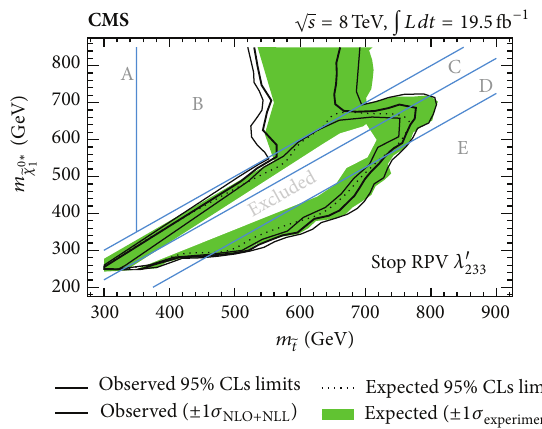
Figure 7: The 95% CL limits in the stop and bino mass plane for stop-pair production and RPV coupling 𝜆 󸀠 233 (from [41]). The different kinematic regions, A, B, C, D, and E are defined in